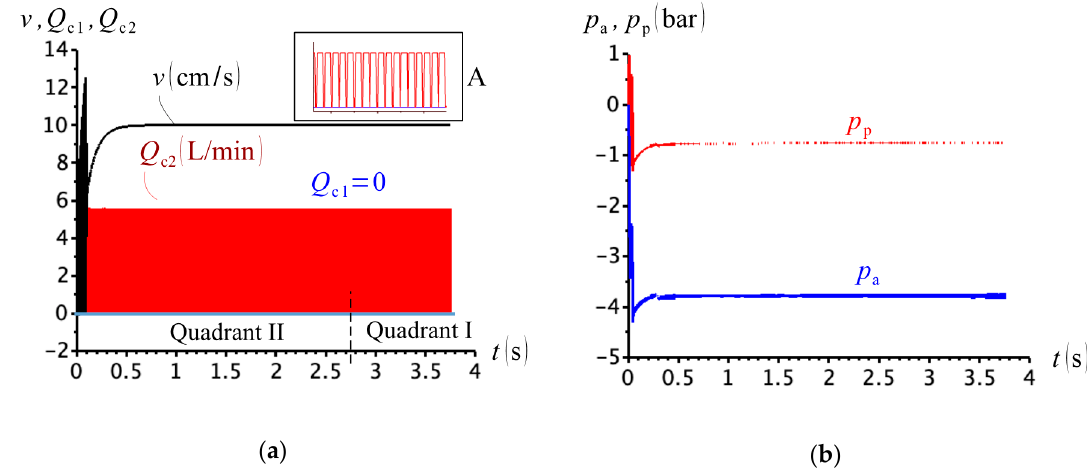
Figure 21. ( a ) Cylinder velocity and compensation flows; ( b ) cap- and rod-side pressures ( (cid:1865) = 0.5 kg and (cid:1868) (cid:2913)(cid:2928) = 3 bar